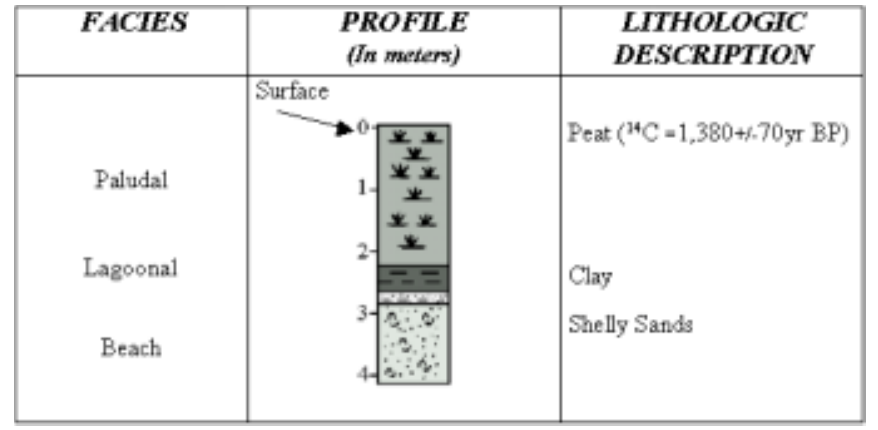
Fig. 6 – Drilling profile at north of Figueirinha Lagoon (28 ◦ 39’01”S/ 48 ◦ 58’43”W), near Jaguaruna town (See geological map – Drilling